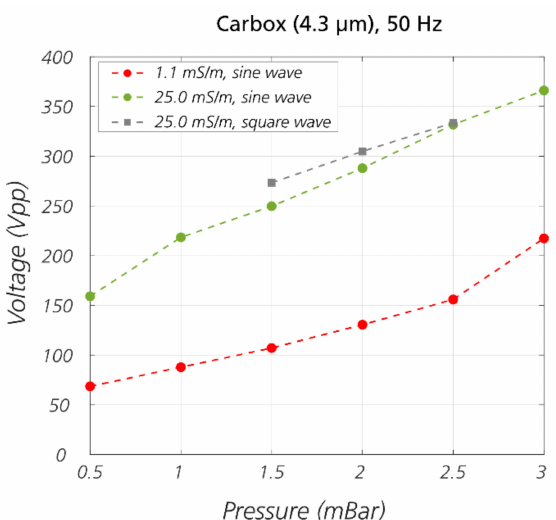
Figure 4. E ff ects of pressure and voltage on displacement of beads in eDLD. The data points are the voltage-pressure pairs that yield 50% displacement. More details about the data analysis can be found in Figure S4 of the Supplementary Information. The experiments were performed on 4.3 µ m carboxylate beads in device #5 ( D C = 6.0 µ m) at 50 Hz, in media at conductivity of 1.1 mS / m or 25 mS / m. Note that the voltages of the square wave data points have been scaled up by a factor of